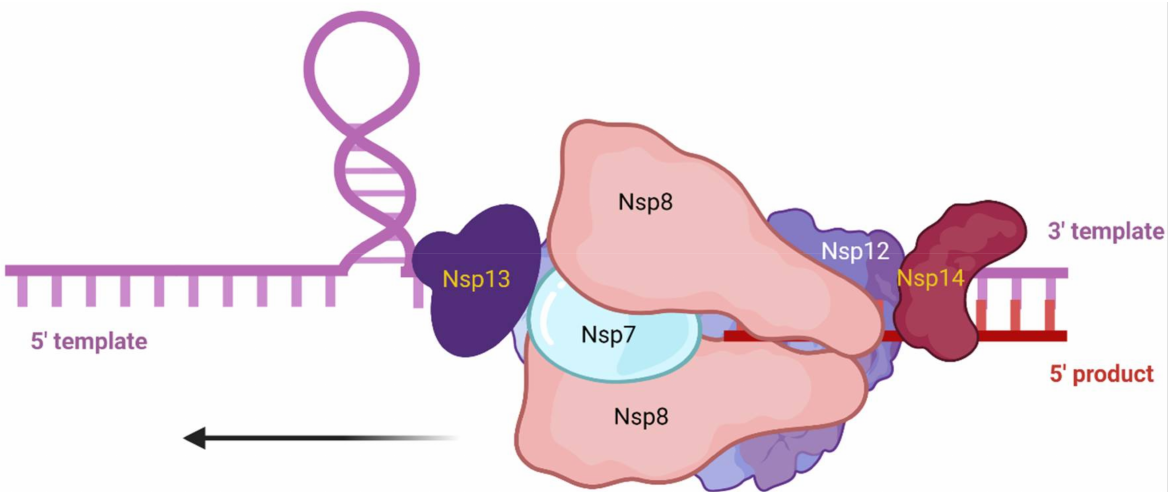
Figure 5. Coronavirus replicase. Coronavirus replicase complex includes the polymerizing subunit, Nsp12, with two copies of Nsp8 and one copy of Nsp7 to complete the functioning RNA-dependent RNA polymerase. Nsp13 interacts with Nsp12 and contains helicase activity to relieve RNA secondary structure in the template RNA. RNA synthesis occurs 5 (cid:48) to 3 (cid:48) as indicated by the arrow. Nsp14 is a novel exonuclease to “proofread” the RNA products and methyltransferase activity involved in methylation of the viral mRNA 5 (cid:48) cap structure. Note: figure is an illustration, not an accurate depiction of the replicase protein structure. Created with